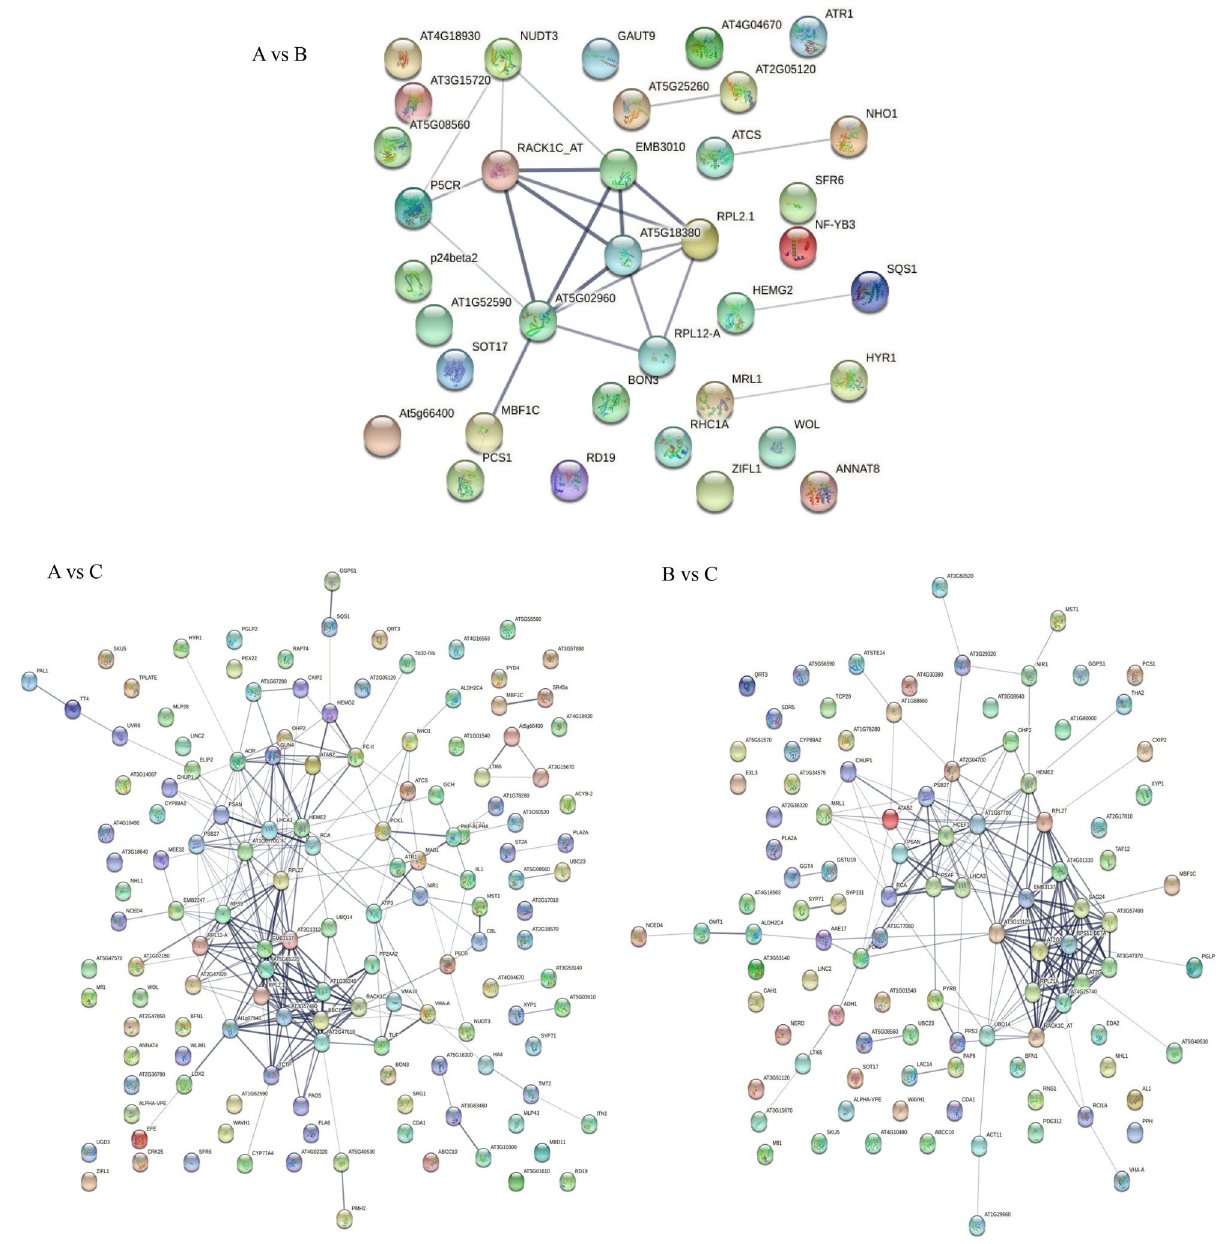
Figure 7. Protein interaction network diagram. Note : The "node" circles represent proteins. Different colors indicate different proteins. The straight line shows the interaction between proteins; the thicker the line, the stronger the